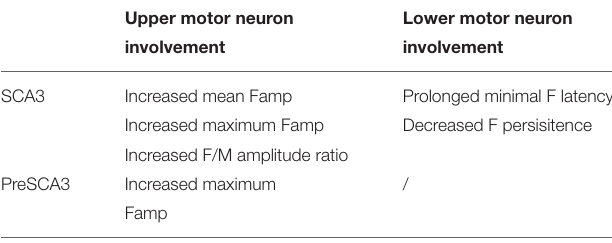
TABLE 4 | F-wave characteristics in SCA3 and